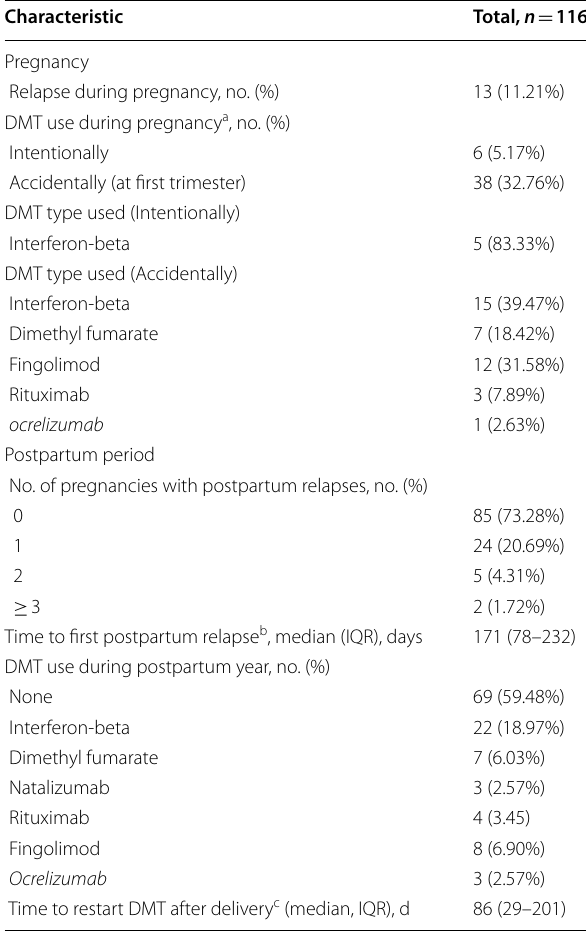
Table 3 The effect of pregnancy and labor on MS outcomes